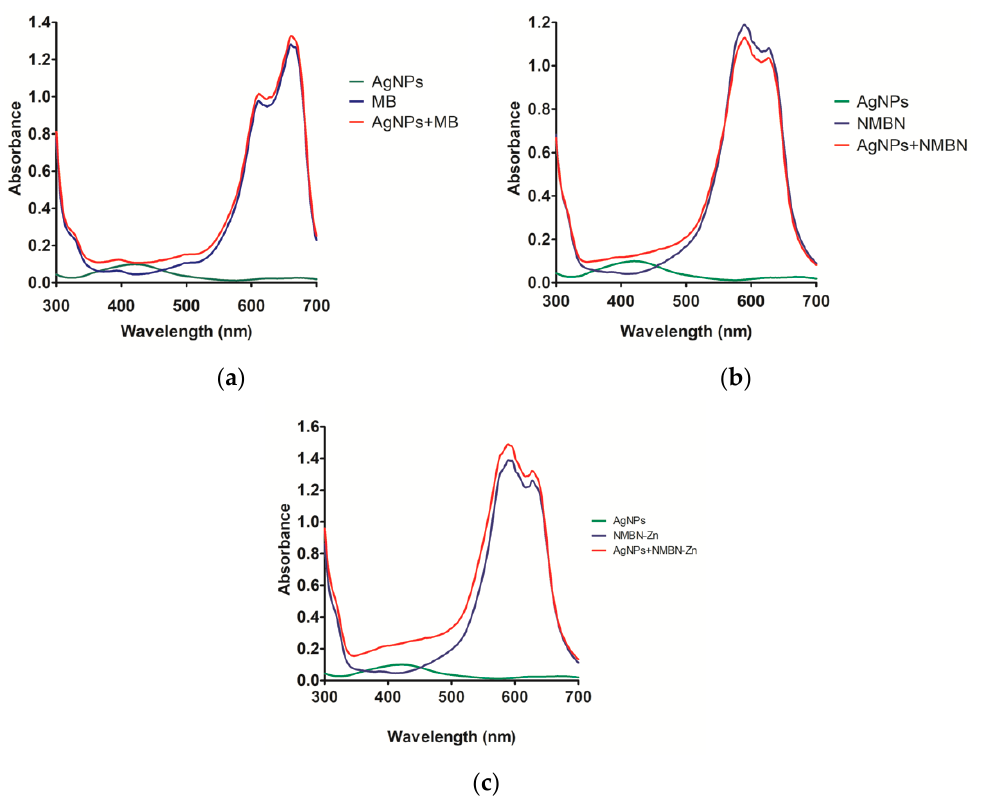
Figure 3. Optical absorption spectrum of AgNPs-PS associations compared to the isolated com- pounds. ( a ) AgNPs (1.51 µg mL − 1 ), MB (6.39 µg mL − 1 ), and AgNPs-MB (1.51 µg mL − 1 and 6.39 µg pounds. ( a ) AgNPs (1.51 µ g mL − 1 ), MB (6.39 µ g mL − 1 ), and AgNPs-MB (1.51 µ g mL − 1 and mL − 1 ); ( b ) AgNPs (1.32 µg mL − 1 ), NMBN (6.95 µg mL − 1 ), and AgNPs-NMBN (1.32 µg mL − 1 and 6.95 6.39 µ g mL − 1 ); ( b ) AgNPs (1.32 µ g mL − 1 ), NMBN (6.95 µ g mL − 1 ), and AgNPs-NMBN (1.32 µ g mL − 1 µg mL − 1 ); and ( c ) AgNPs (2.56 µg mL − 1 ), NMBN-Zn (8.33 µg mL − 1 ), and AgNPs-NMBN-Zn (2.56 µg and 6.95 µ g mL − 1 ); and ( c ) AgNPs (2.56 µ g mL − 1 ), NMBN-Zn (8.33 µ g mL − 1 ), and AgNPs-NMBN-Zn mL − 1 and 8.33 µg mL − 1 ). (2.56 µ g mL − 1 and 8.33 µ g mL − 1